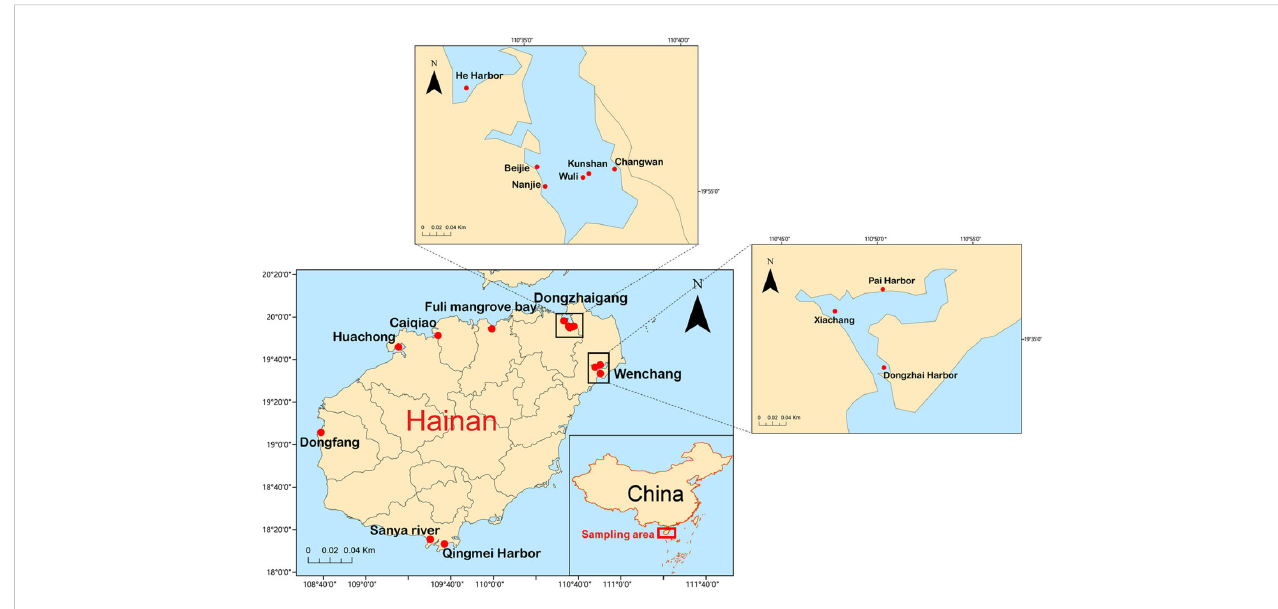
FIGURE 1 Sampling locations in typical mangrove areas of Hainan,